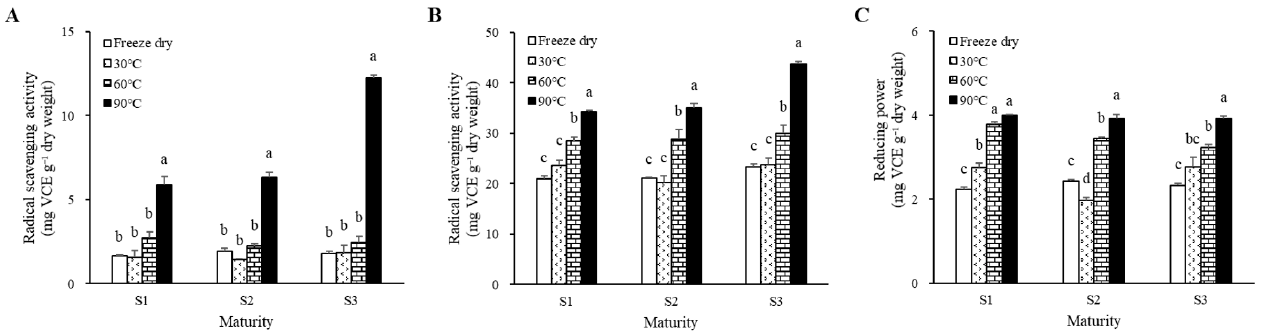
Figure 2. Radical scavenging activity of ( A ) DPPH and ( B ) ABTS and ( C ) reducing power evaluated using FRAP assay according to drying temperature of different maturities of M. charantia fruit. Different letters within each maturity stage indicate significant differences according to Tukey’s studentized test at p < 0.05.